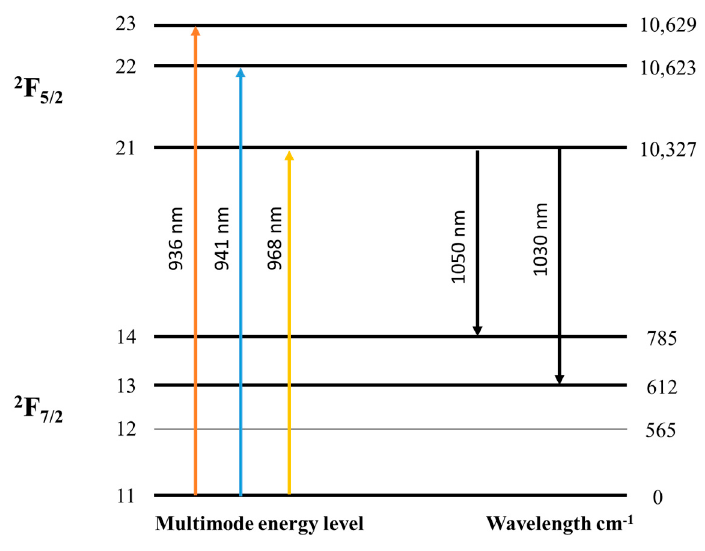
Figure 7. Yb 3+ energy level structure in Yb:YAG.